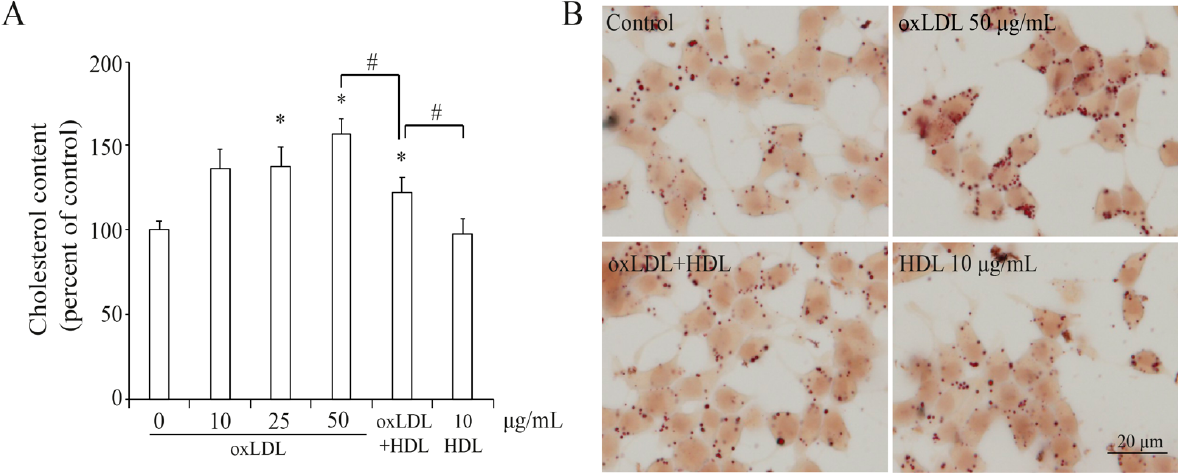
Figure 2. The effect of OxLDL on the cholesterol accumulation in INS-1 cells. ( A ). Percentage of cholesterol content normalized by protein concentration referred to control is presented as the mean ± SEM ( n = 3) of separate experiments in the graph. * p < 0.05 compared to control; # p < 0.05 compared to OxLDL + HDL. ( B ) Oil Red O stain of INS-1 cells treated with OxLDL or plus HDL. Bar = 20 μ m.